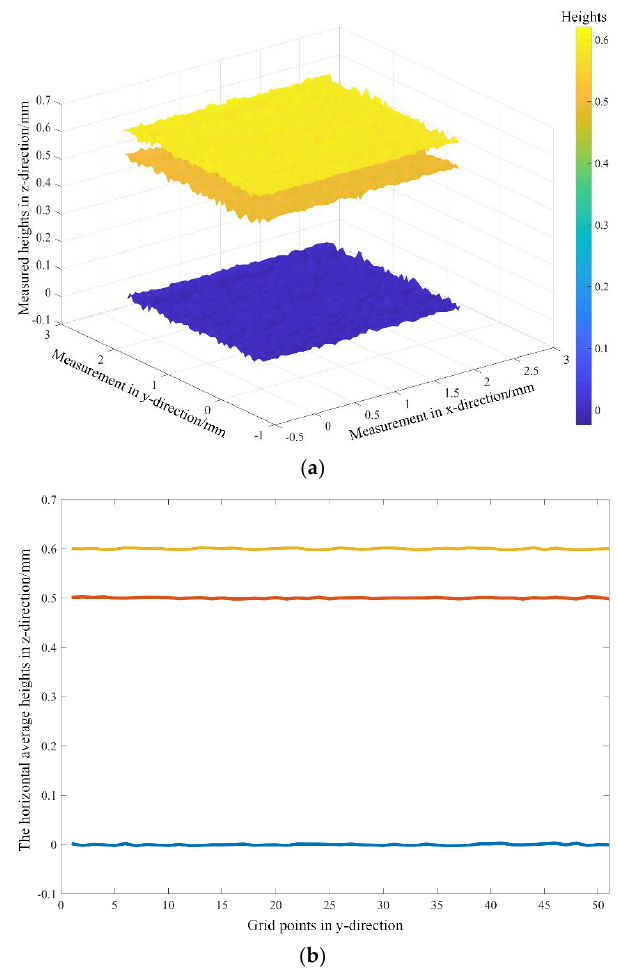
Figure 2 . The reconstructed results of the grid arrays at three different locations. ( a ) The surfaces fitted from the reconstructed grid arrays at three different locations in an easy-to-view angle; ( b ) three lines formed by averaging the three surfaces in Figure 2a in x - direction.